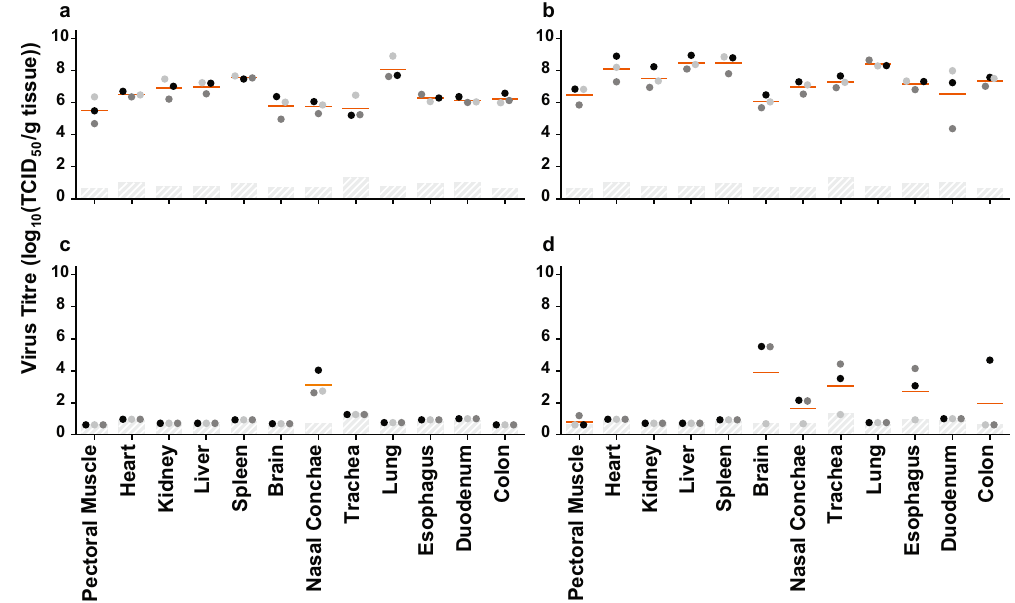
Figure 2. Viral titres in organs of chickens inoculated with INDO WT or INDO AT6 . ( a ) Individual viral titres in organs of chickens inoculated with INDO WT at 24 hpi. ( b ) Individual viral titres in organs of chickens inoculated with INDO WT at the time of death. ( c ) Individual viral titres in organs of chickens inoculated with INDO AT6 at 24 hpi. ( d ) Individual viral titres in organs of chickens inoculated with the INDO AT6 virus at the time of death. Lower limits of detection are indicated by the light grey bars. Means are indicated by the orange lines.